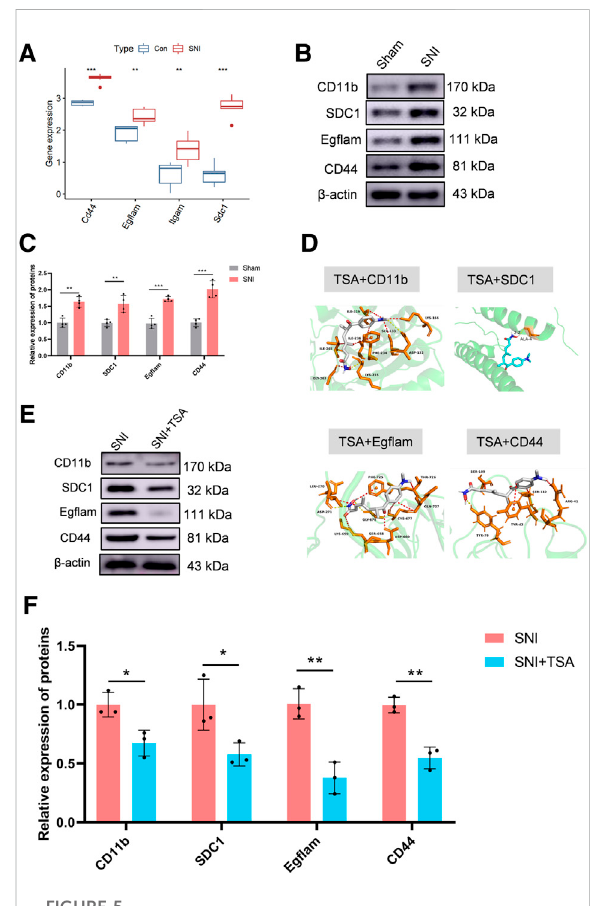
FIGURE 5 Validation of key genes and targeted drug prediction. (A) ExpressionofkeygenesintheGSE96051andGSE161342datasets. (B) Westernblotwasemployedtoverifykeygenes. (C) Proteindata quanti fi cation from (B) . (D) Proteins and small molecular compound docking simulation. (E) Western blot was employed to verify the level of proteins in DRG after SNI. (F) Protein data quanti fi cation from (E) . Data are provided as mean ± SD, with n = 4 per treatment. ** p < 0.01 and *** p < 0.001 are deemed signi fi